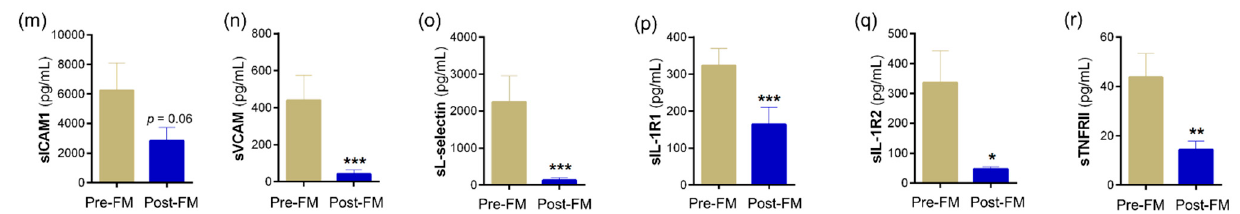
Figure 3. Tear fluid soluble factors decreased during face-mask-wearing era. Bar graphs represent the levels of cytokines—( a ) IL-6, ( c ) IL-12/23p40, ( d ) IL-13, ( e ) IL-18, ( f ) TNF α ; chemokine—( b ) IL-8,